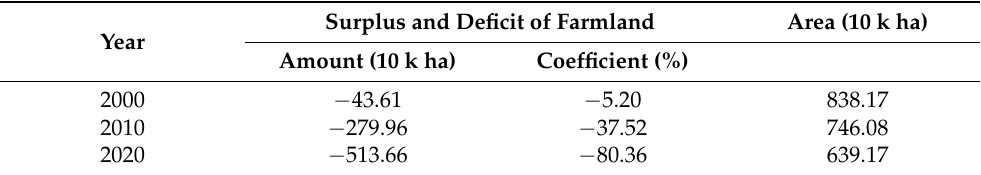
Table 2. Farmland surplus and deficit at urban agglomeration scale.